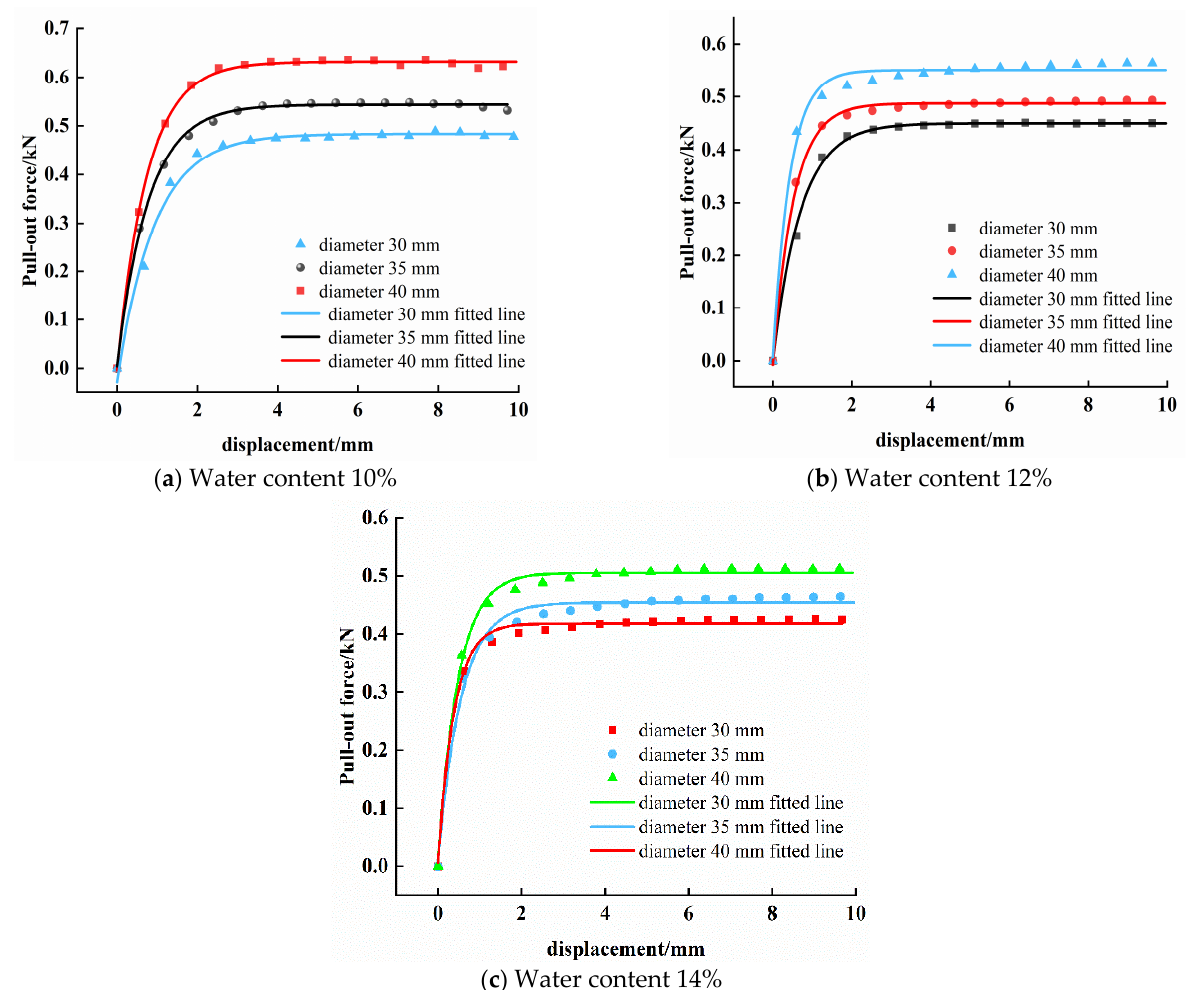
Figure 7. Load-bearing capacity-displacement curves for bolts of different diameters.